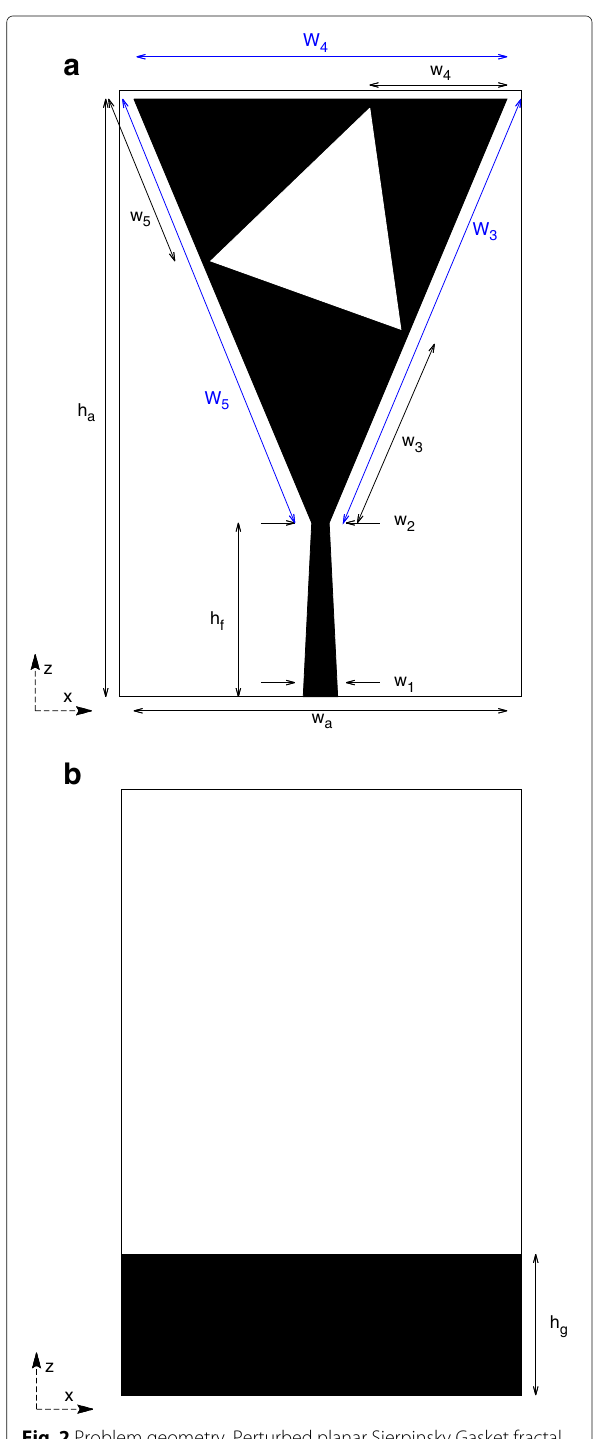
Fig. 2 Problem geometry. Perturbed planar Sierpinsky Gasket fractal antenna and antenna descriptors: ( a ) front and ( b ) back